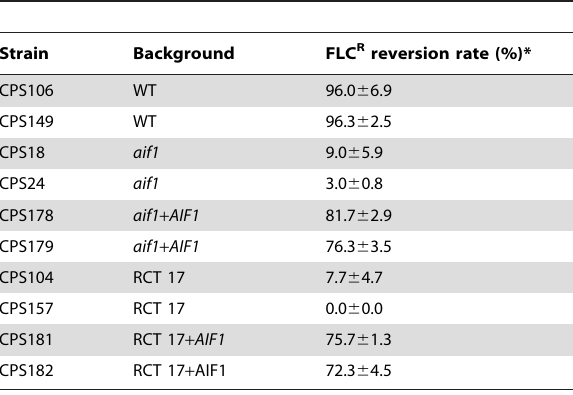
Table 4. Reversion rates of resistance to FLC after 20 generations